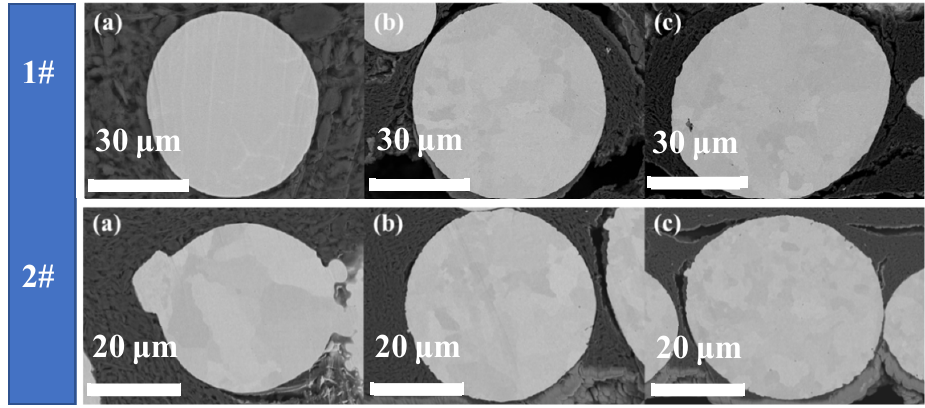
Figure 6. 1# ( a – c ) and 2# ( a – c ) SEM morphology of cross-section of and powders with different particle sizes.